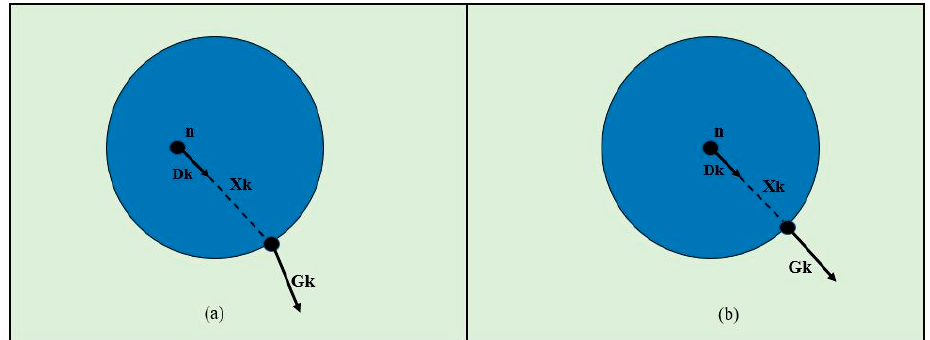
Figure 4. A contrived example is having a dark-colored circle against a light background, similar to an iris and sclera. In ( a ) D k (displacement vector) and G k (gradient vector) do not have same direction but in ( b ) the orientations are same.